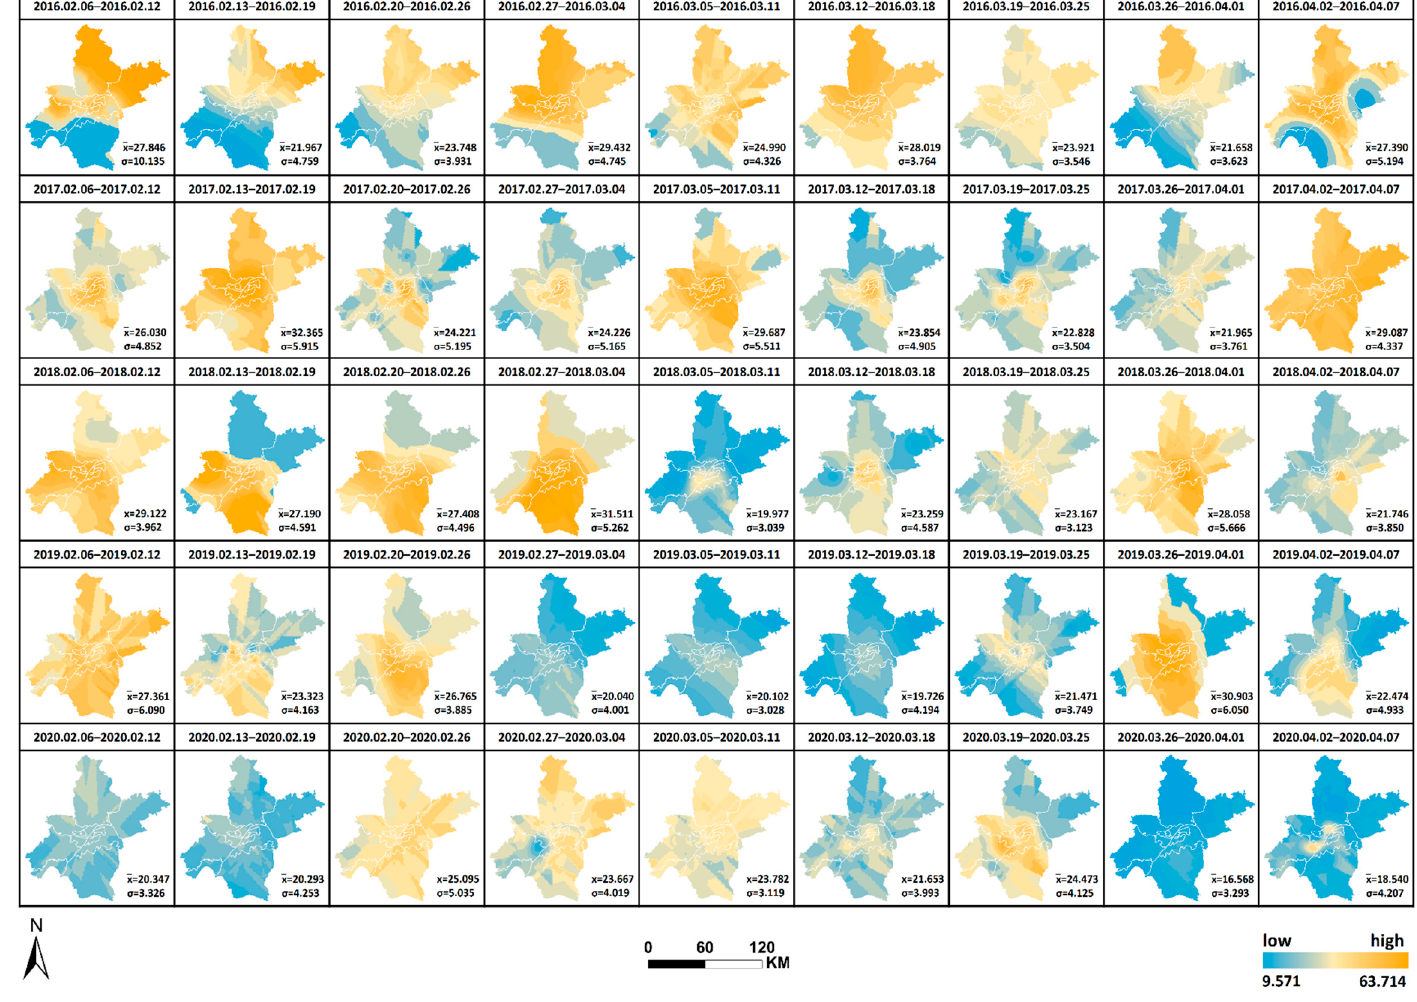
Figure 11. CO interpolation chart from 2016 to 2020.